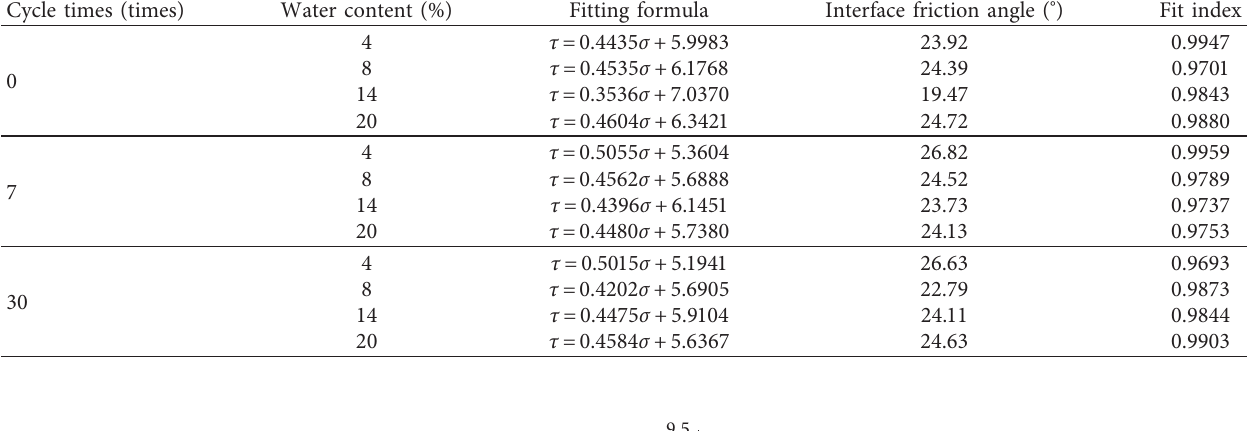
Table 4: Relationship between shear stress and normal